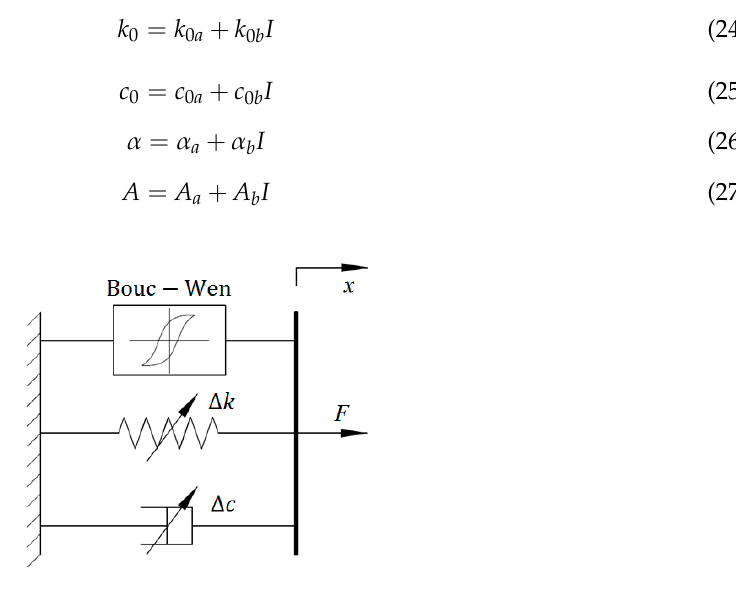
Figure 5. Improved BW model.